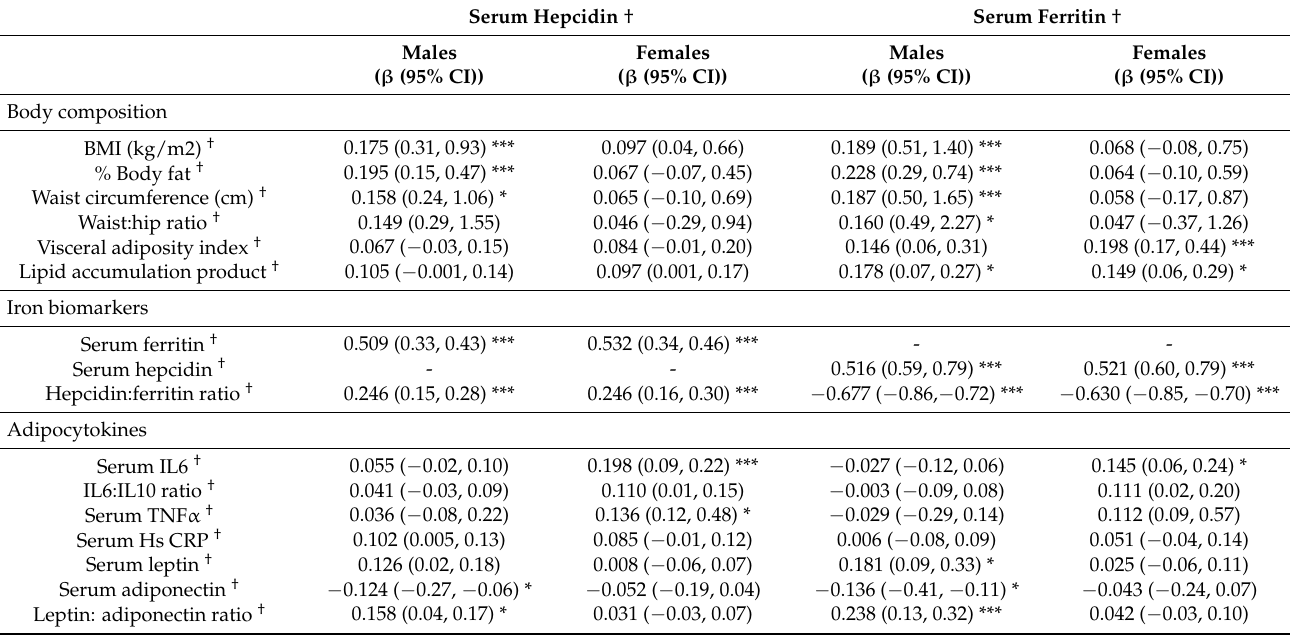
Table 3. Adjusted linear regression analysis for predictors of serum hepcidin and serum ferritin. Serum Hepcidin † Serum Ferritin † Males Females Males ( β (95% CI)) ( β (95% CI)) ( β (95%